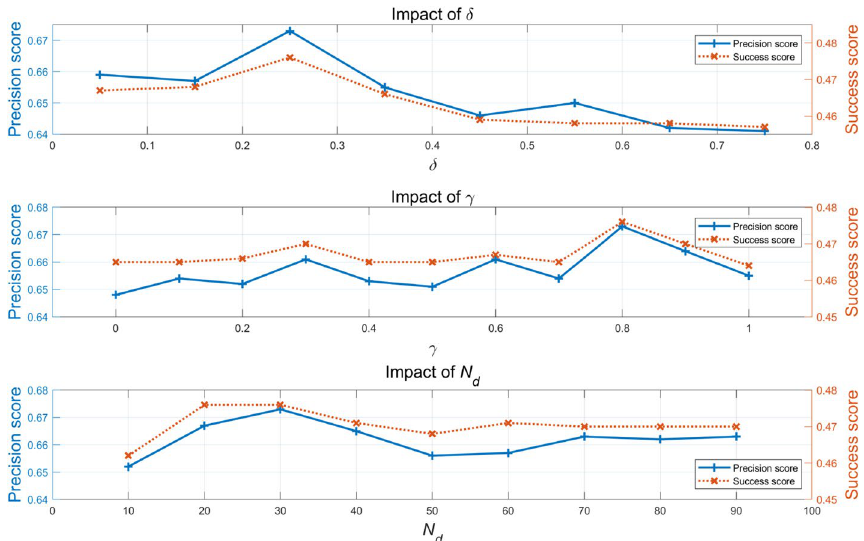
Fig. 11 Tracking performance of precision and success scores versus three varying parameters on the UAV123@10fps